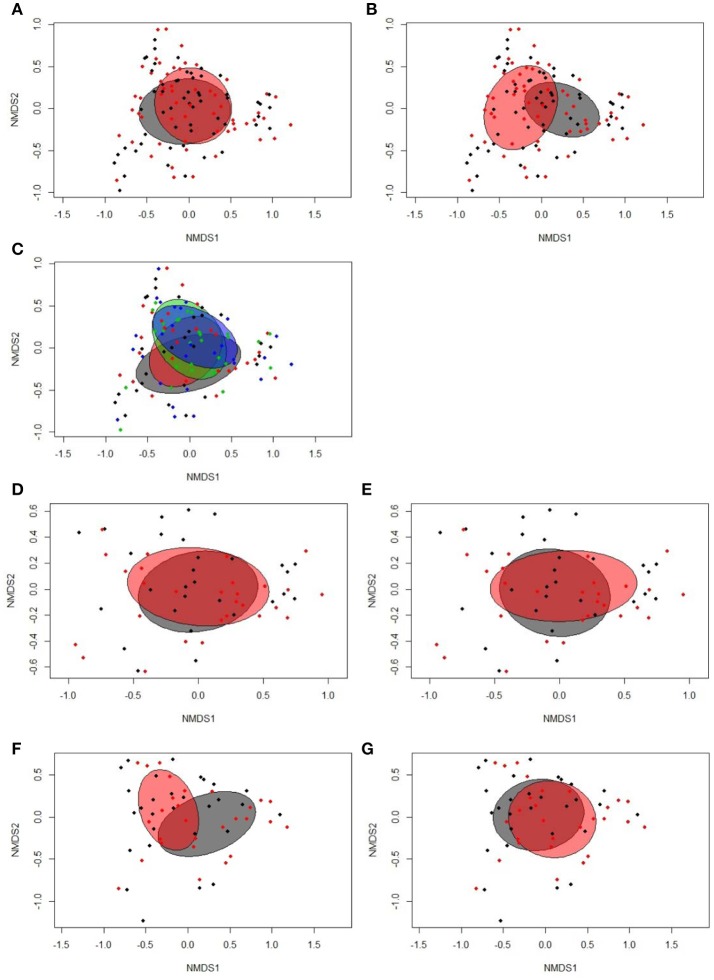
Two-dimensional non-parametric multidimensional scaling (NMDS) ordination plots of (A) fecal samples of females (gray) and males (red; Bray-Curtis dissimilarity, P = 0.398); (B) fecal samples at 16 (gray) and 29 days (red) post-hatch (dph; Bray-Curtis dissimilarity, P = 0.001); (C) fecal samples separated by treatment groups across time points (blue, restrictively fed low RFI; green, restrictively fed high RFI; red, ad libitum low RFI; gray, ad libitum fed high RFI; Bray-Curtis dissimilarity, P = 0.153); (D) fecal samples from ad libitum (gray) and restrictively (red) fed chickens on 16 dph (Bray-Curtis dissimilarity, P = 0.841); (E) fecal samples from low (gray) and high RFI (red) chickens on 16 dph (Bray-Curtis dissimilarity, P = 0.260); (F) fecal samples from ad libitum (gray) and restrictively (red) fed chickens on 29 dph (Bray-Curtis dissimilarity, P = 0.001); (G) fecal samples from low (gray) and high RFI (red) chickens on 29 dph (Bray-Curtis dissimilarity, P = 0.283). Low RFI ad libitum, n = 7 per sex and time point; high RFI ad libitum, n = 8 females at 16 dph and n = 7 females at 29 dph, and n = 7 males per time point; low RFI restrictive, n = 6 females at 16 dph and n = 7 females at 29 dph, and n = 7 males per time point; high RFI restrictive, n = 7 per sex and time point.